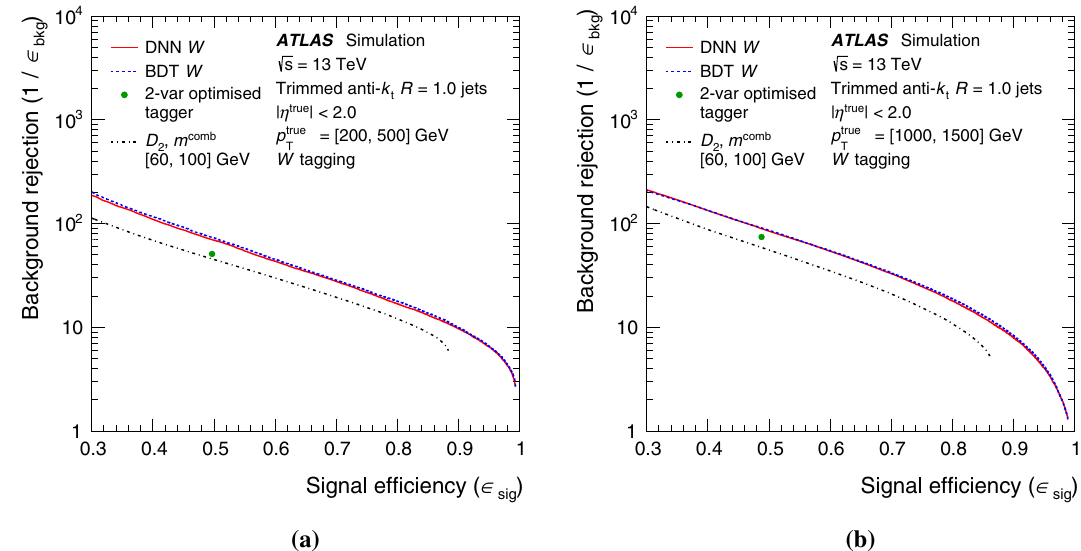
Fig. 7 The performance comparison of the W -boson taggers in a low- p true distribution of the signal jets weighted to match that of the dijet background samples